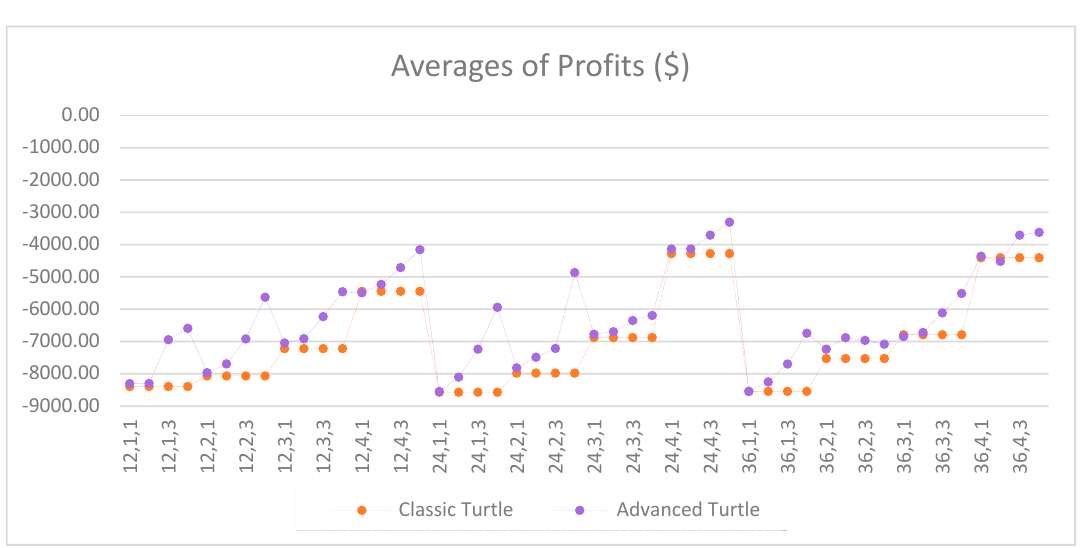
Figure 9. Averages of profits between the classic and the advanced Turtle systems for every combination of N, X, Y for the fast parameters (20, 40).